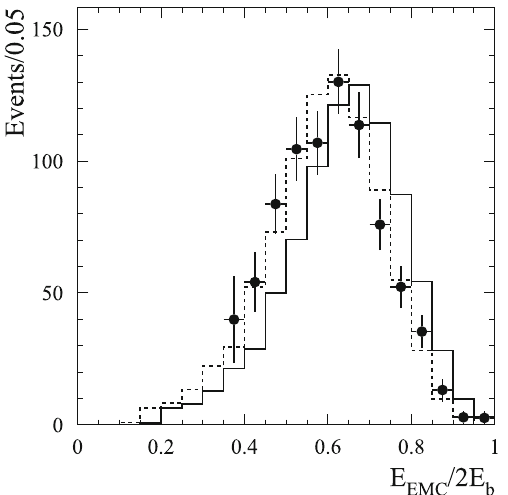
spectra for n ¯ n events in data and simulation. The spectra for two energy intervals of the 2019 run are shown in Fig. 12.